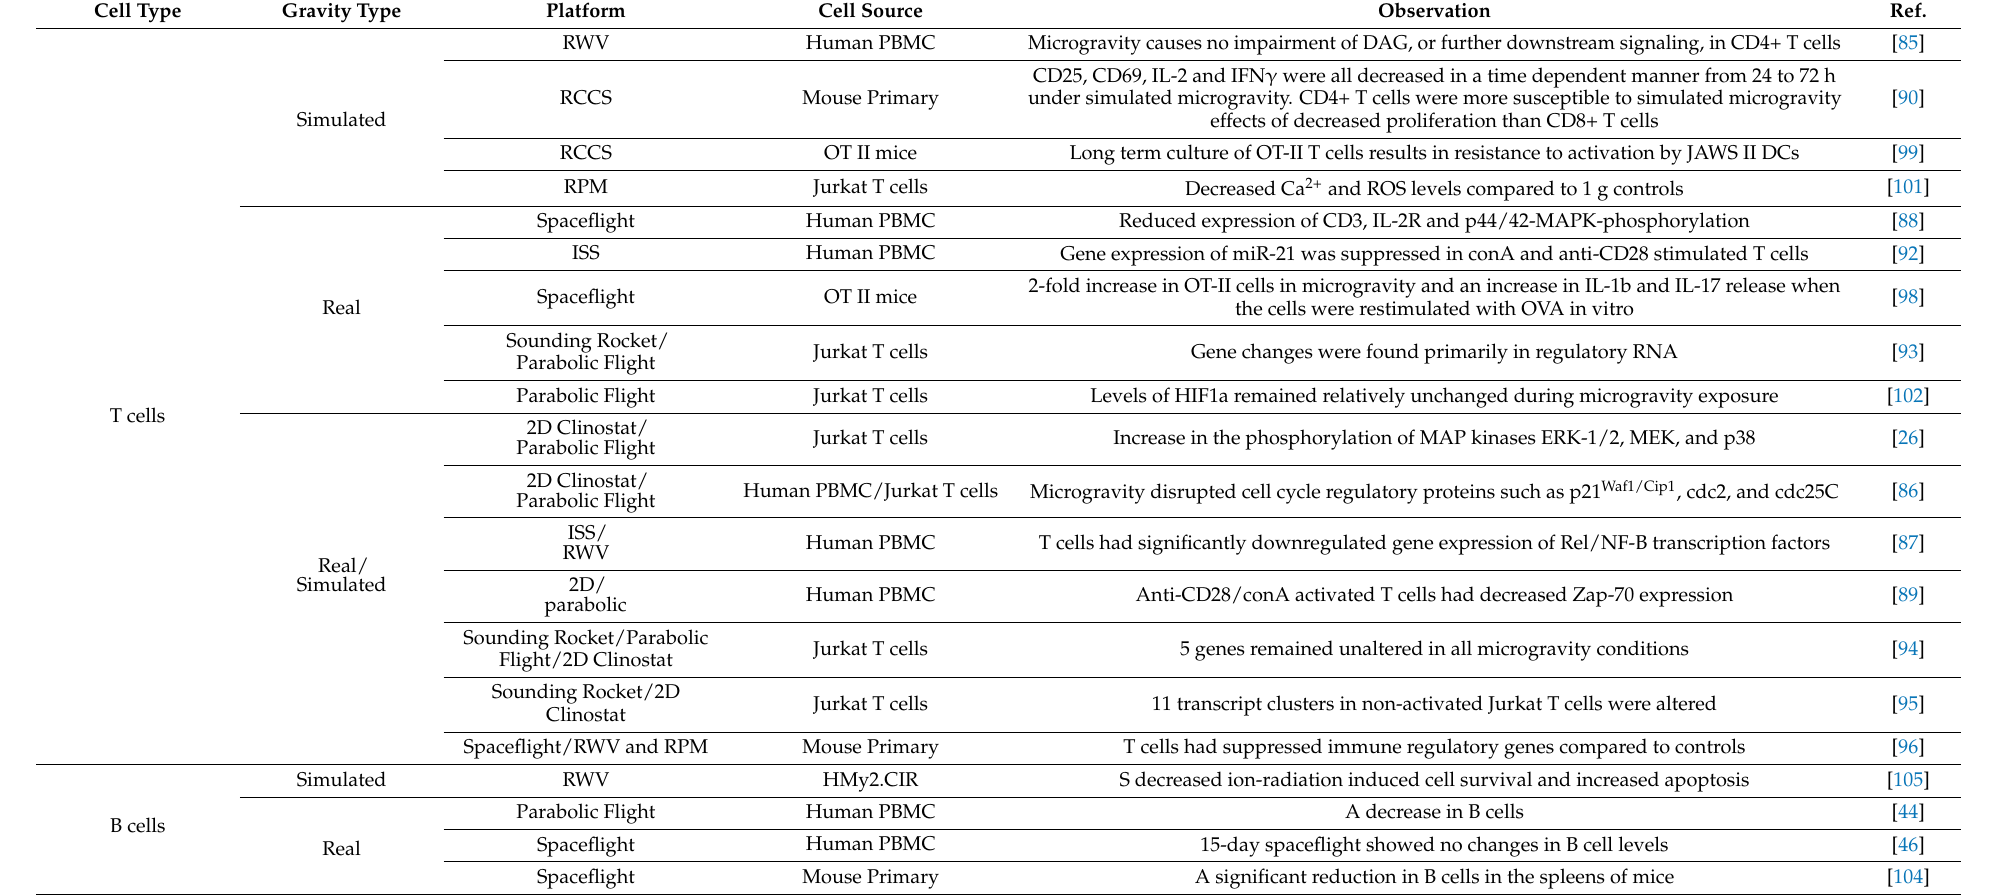
Table 2. Overview of the effects of microgravity on cells of the adaptive immune